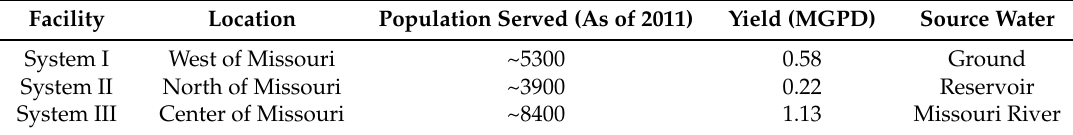
Table 1. Description of the three selected small drinking water systems.